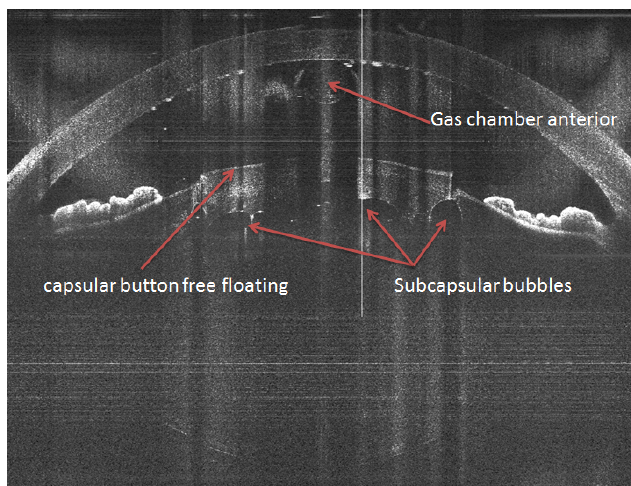
Figure 5. A complete capsulotomy is seen with the capsular button free floating in the anterior chamber, while there is nearly no accumulation of gas in the fragmented lens. There are minimal subcapsular bubbles in the anterior chamber.